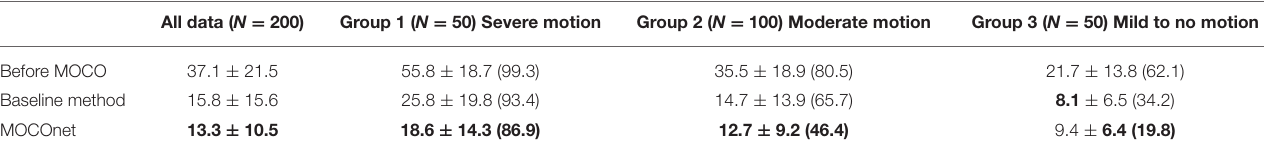
TABLE 1 | Human observer assessment of motion extent (%) on 200 T1 maps before motion correction, and after the baseline and proposed method (MOCOnet) for motion correction.